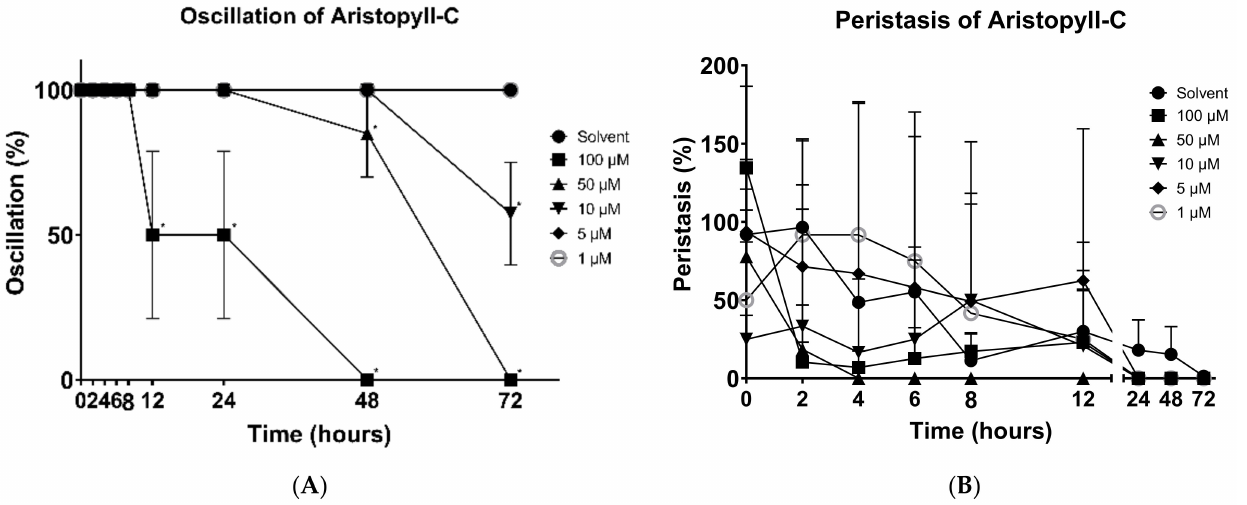
Figure 4. Effects of aristophyll-C on H. nana , treated with different concentrations of aristophyll-C (1, 5, 10, 50, and 100 µ M), with incubation times of 2, 4, 6, 8, 12, 24, 48, and 72 h. Time courses of effects on oscillation ( A ) and peristalsis ( B ) are presented as percentages. Solvent was 0.1% DMSO. Each value is the mean ± SD of three individual experiments; * p < 0.05 indicates a significant difference from the result for vehicle-treated